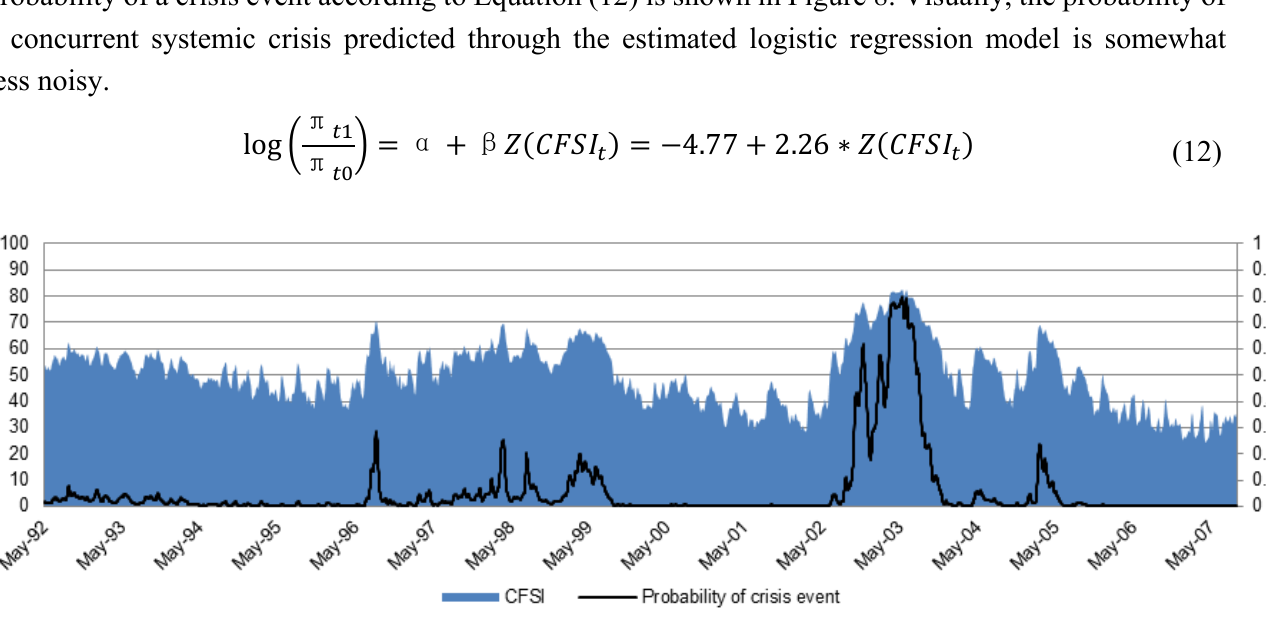
Figure 8. Implied probability of system stress episode (right axis) given the level of CFSI (left axis). Patterns in the volatility of asset returns change over time and across markets (see [45–47]).